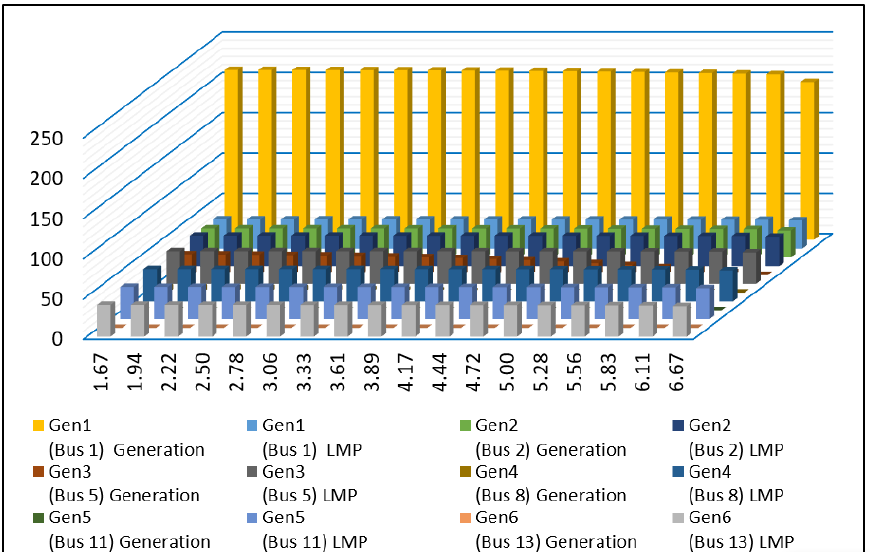
Figure 4. Generation (in MW) and LMP (in $/MWh) without wind placement.